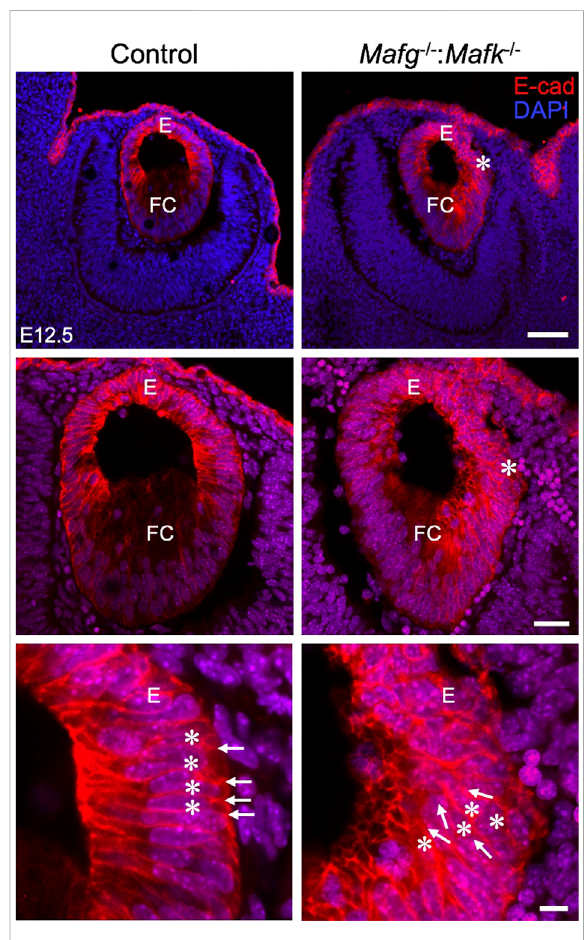
FIGURE 2 Mafg − / − : Mafk − / − mice exhibit abnormalities in the lens epithelium at E12.5. Immunostaining for E-Cadherin and co- staining with DAPI shows that early in lens development, at stage E12.5, Mafg − / − : Mafk − / − lens exhibits regions of disorganization intheepithelium(asterisksinrow1,row 2)comparedto control.In row 3, cell boundaries (arrows) revealed by E-cadherin staining and nuclei stained by DAPI (asterisks) appear in a uniform manner in the control, but not in Mafg − / − : Mafk − / − lens, wherein they appear disorganized.Abbreviation:E,Epitheliumofthelens;FC,Fibercells of the lens. Scale bar for Row 1, 20 μ m; Row 2, 10 μ m; Row 3, 8 μ